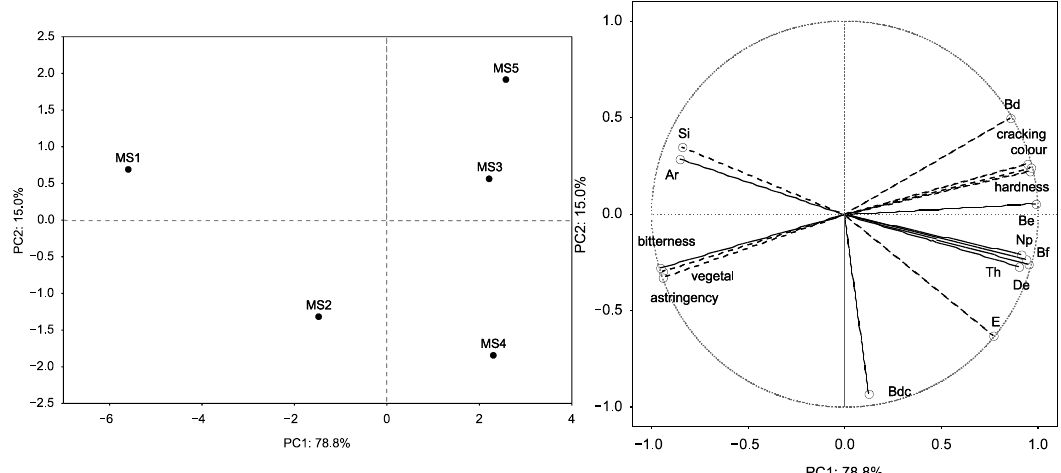
Figure 5. Distribution of samples in the plane defined by the two first discriminate functions by maturity stage and projection of the variables on the factor-plane extracted by PCA. As can be seen, a separation by ripening was achieved. On one hand, color, cracking and hardness (both instrumental and sensory for the latter), together with other mechan- ical parameters, were found at the positive end of the first axis and were therefore posi- tively correlated with the MS3, MS4 and MS5. On the other hand, the instrumental Si and Ar, and the sensory vegetal, bitterness and astringency parameters were found at the neg- ative end of the first axis, positively correlated with MS1 and MS2.